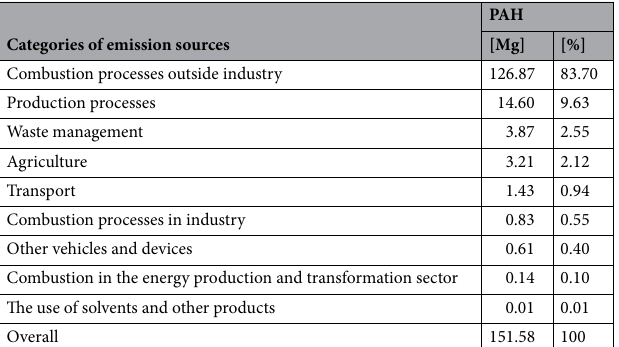
Table 1. Estimated annual PAH emission in Poland in 2017, including emission sources (according: KOBiZE, 2019).